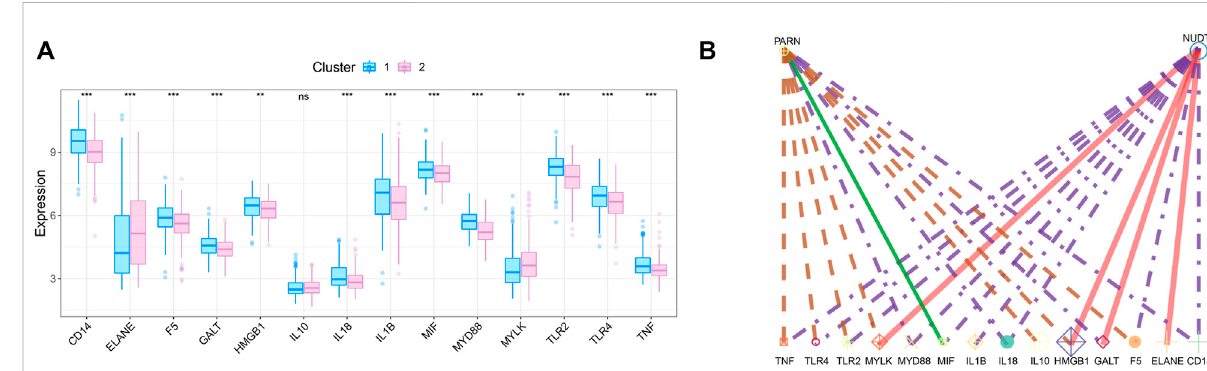
FIGURE 6 Correlationanalysisofm7G-relatedgenesandsepsisgene. (A) Theexpressiondifferenceofsepsis-relatedgenesbetweenthetwosubtypes. (B) Regulatory network of key genes and sepsis-related